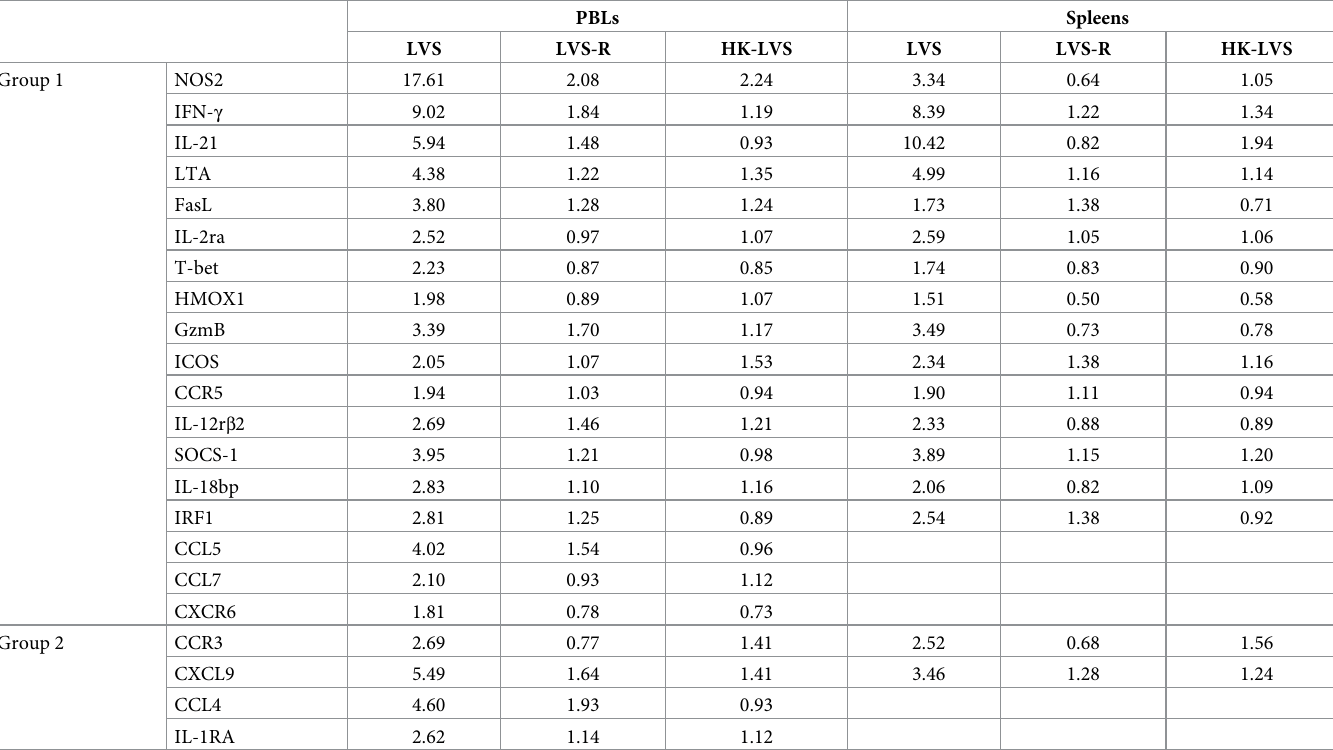
Table 1. Relative gene expression of potential correlates of protection in co-cultures using immune leukocytes from differentially vaccinated